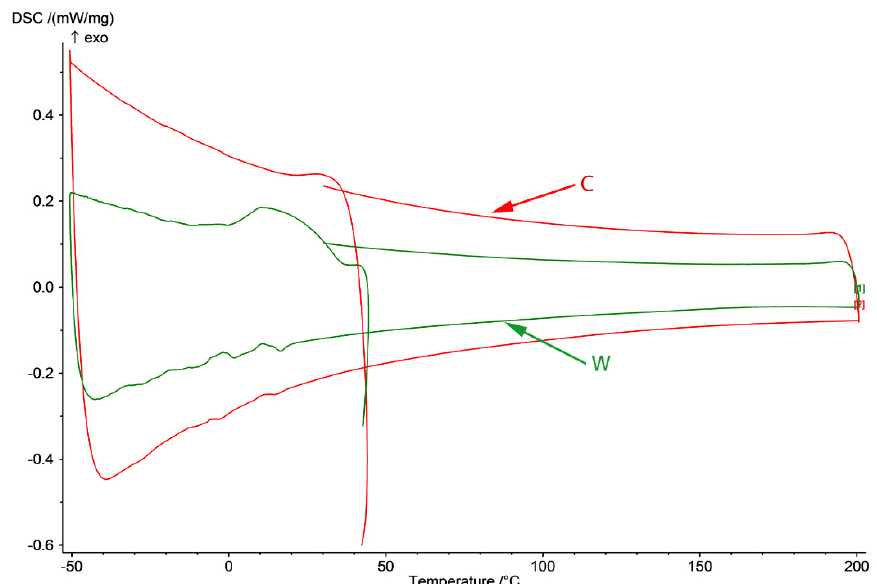
Figure 3. DSC diagram of C and W samples in − 50 to 200 °C domain (heating from 25 to 200 °C and cooling to − 50 and back to 25 ◦ C) and γ - ε forward transformation through cooling and ε - γ reverse cooling to − 50 and back to 25 °C) and γ - ε forward transformation through cooling and ε - γ reverse transformation through transformation through heating.